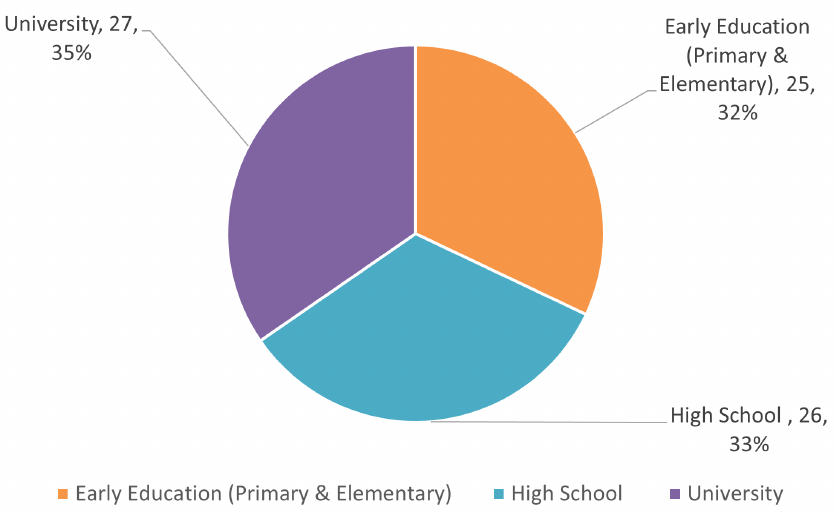
Figure 4. AR studies distribution according to educational